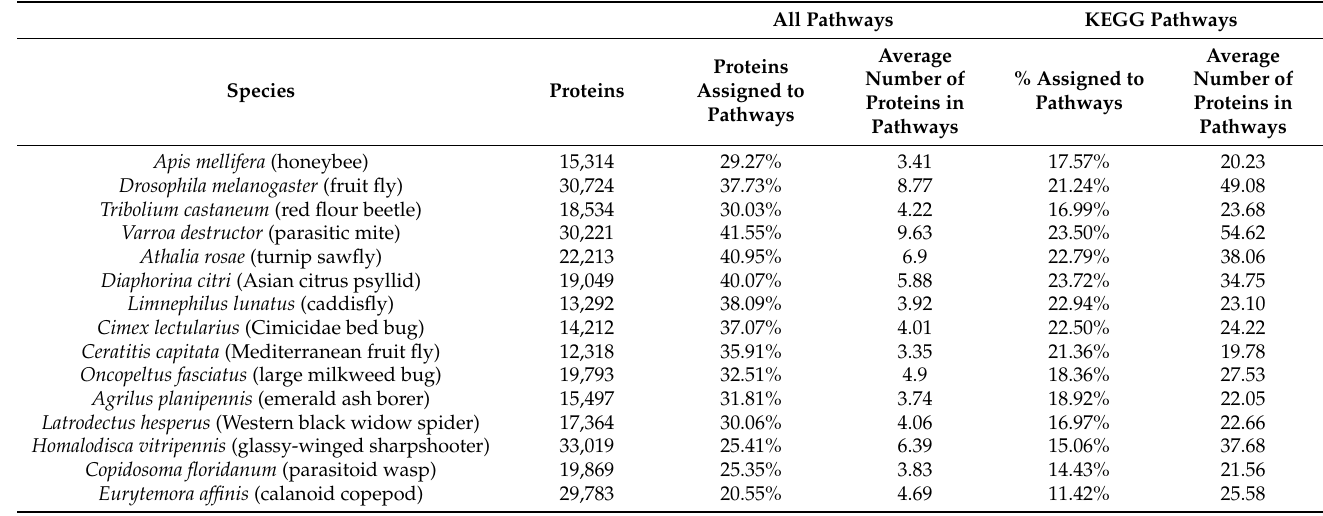
Table 6. KOBAS results for arthropod genomes selected for this study. The test species are sorted by the overall proportion of proteins assigned to